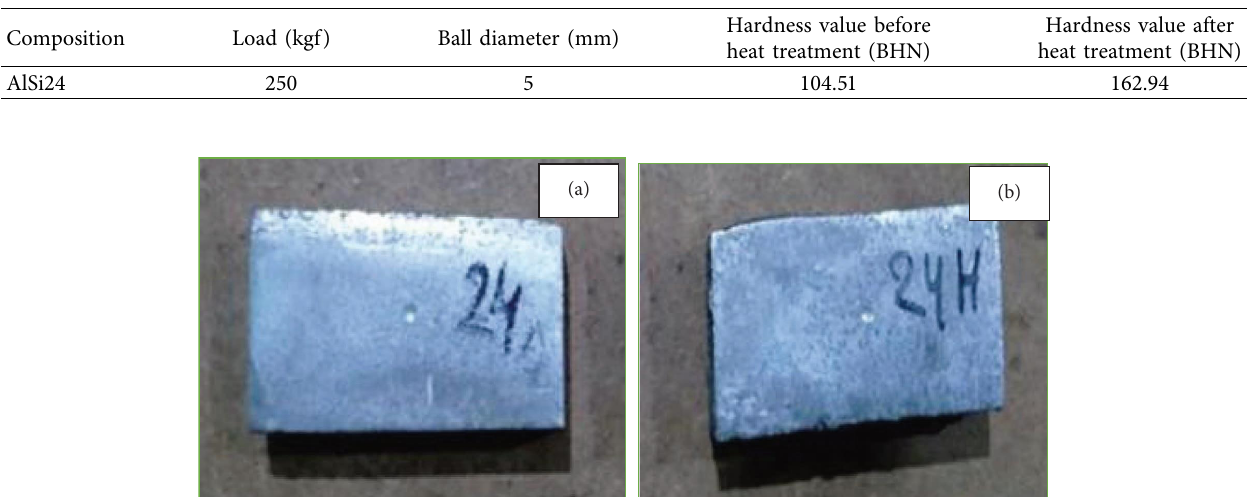
Table 5: Hardness values of AlSi24 composite.